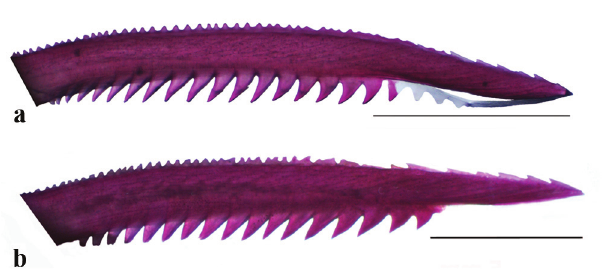
Fig. 5 . Pectoral-fin spines in Pimelodella from the Miranda River. a ) 2n = 46; b ) 2n = 52. Scale bar = 5